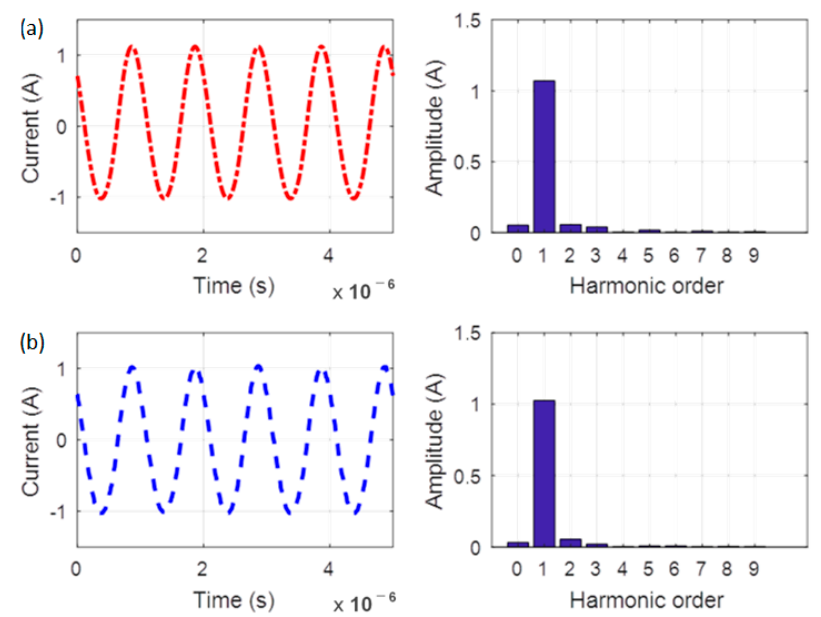
Figure 17. The FFT analyses of: ( a ) receiver current waveform I o obtained from the simulation and ( b ) receiver current waveform I o obtained from the measurements.